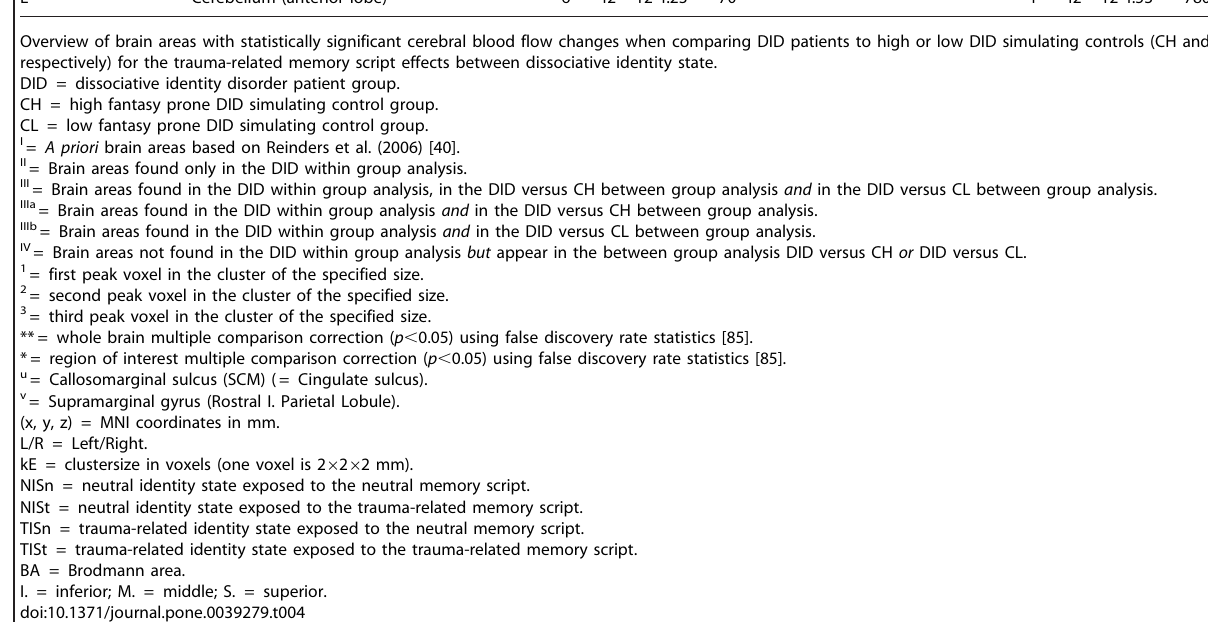
Withingroup Betweengroup